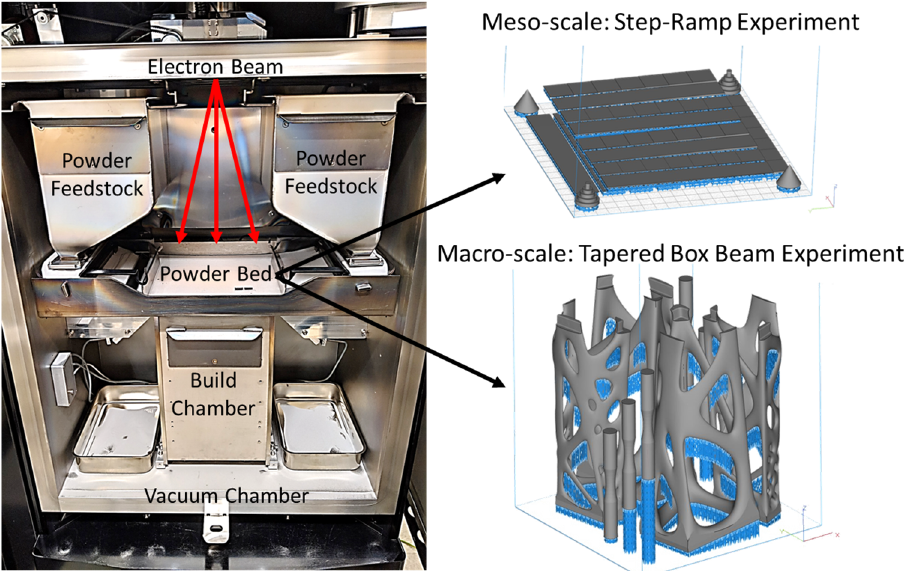
Figure 1. Image of the Arcam A2X EB-PBF experimental setup along with the build volume input models of the meso-scale step-ramp experiment and the macro-scale tapered box beam experiment. The experimental specimens are colored gray, while support features are shown in blue.